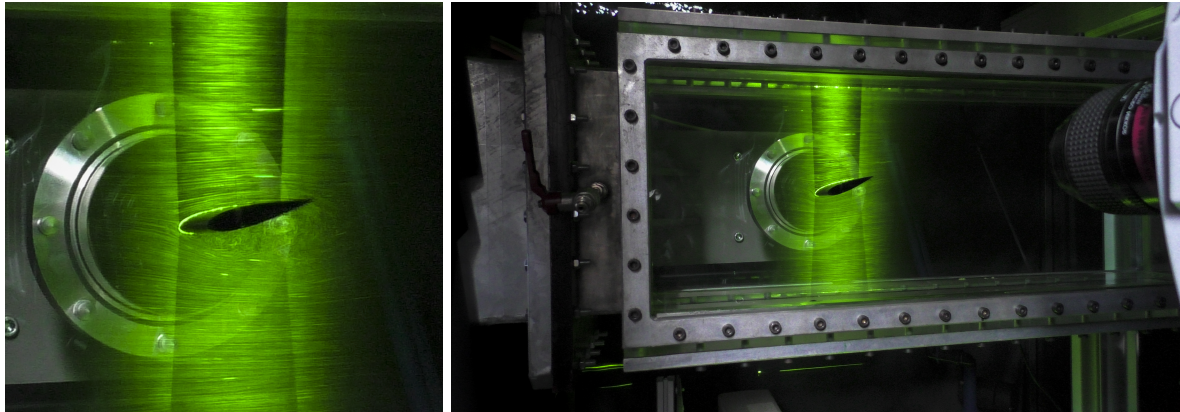
Figure 4. Setup of the two-dimensional, two-component (2D2C) particle image velocimetry (PIV) measurement with two synchronized lasers and high-speed camera at the LEGI labs closed-loop water tunnel. ( Left ) Detail of the inclined rigid hydrofoil, with flow separation. ( right ) The high-speed camera appears in the right of the image. Pathlines of particles are partly visible. Photos by Nicole Lambert, CNRS/LEGI 2017.